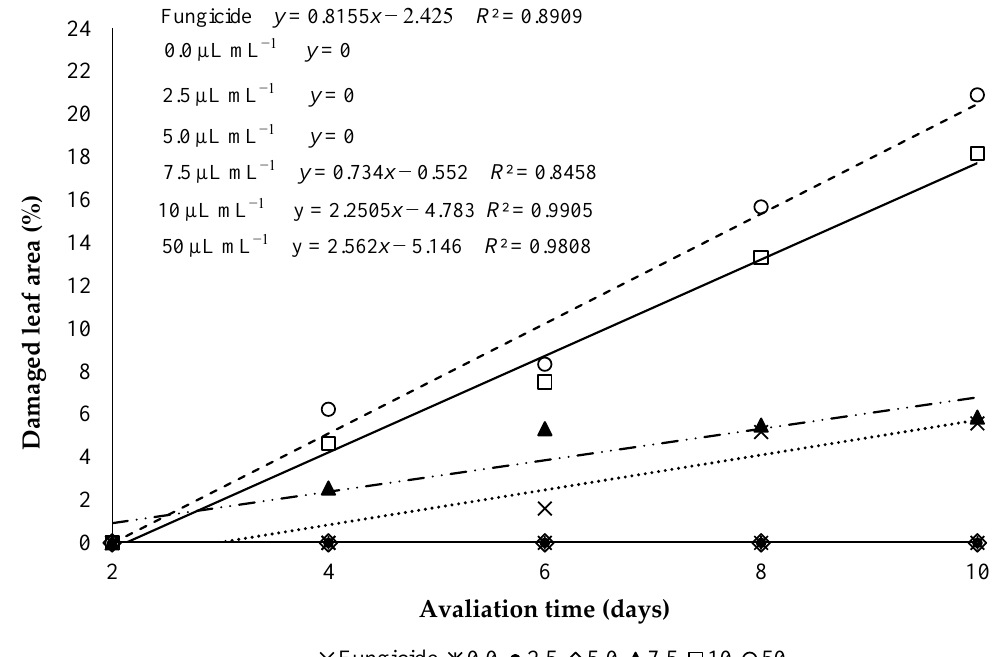
Figure 2. Phytotoxicity (Damaged leaf area x Incubation days) of different C. citratus essential oil concentrations in maize plants. Treatments (2.5 µ L mL − 1 , 5 µ L mL − 1 , 7.5 µ L mL − 1 , 10 µ L mL − 1 , and 50 µ L mL − 1 ) positive control (distilled water), negative control—(fungicide—methyl-thiophanate 2 mg mL − 1 ).